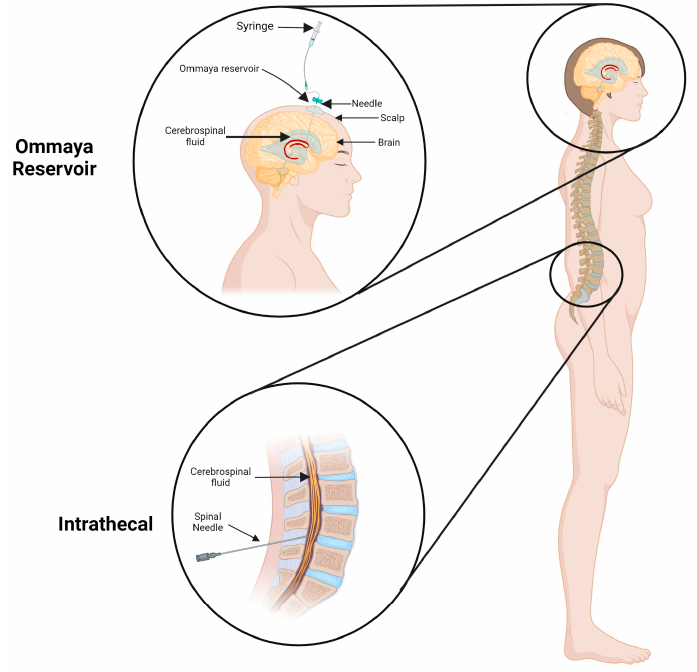
Figure 2. Routes of drug administration into the central nervous system. Intracerebroventricular administration through the Ommaya reservoir into lateral ventricles and intrathecal administration through the spinal column.